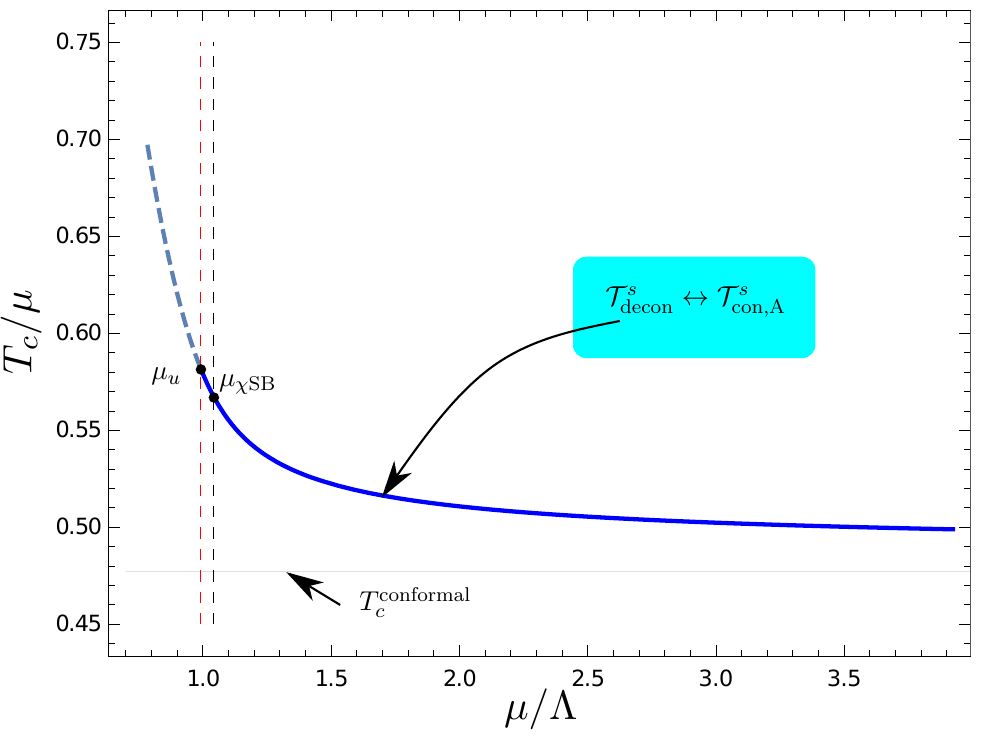
s s decon ↔ T con , A T